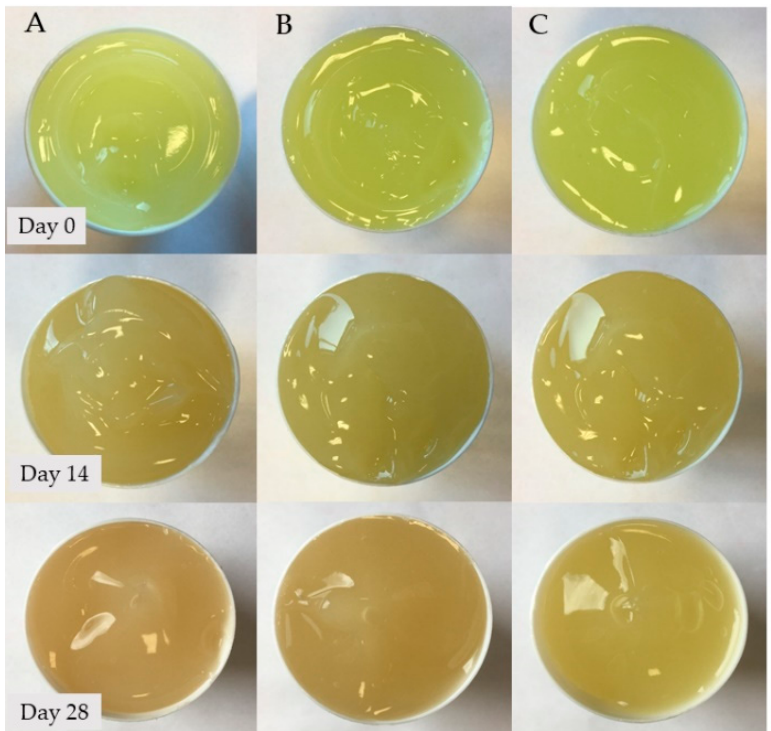
Figure 3. Colour changes of hydrogel preparations ( A–C ) noted during the 28-day observation period.